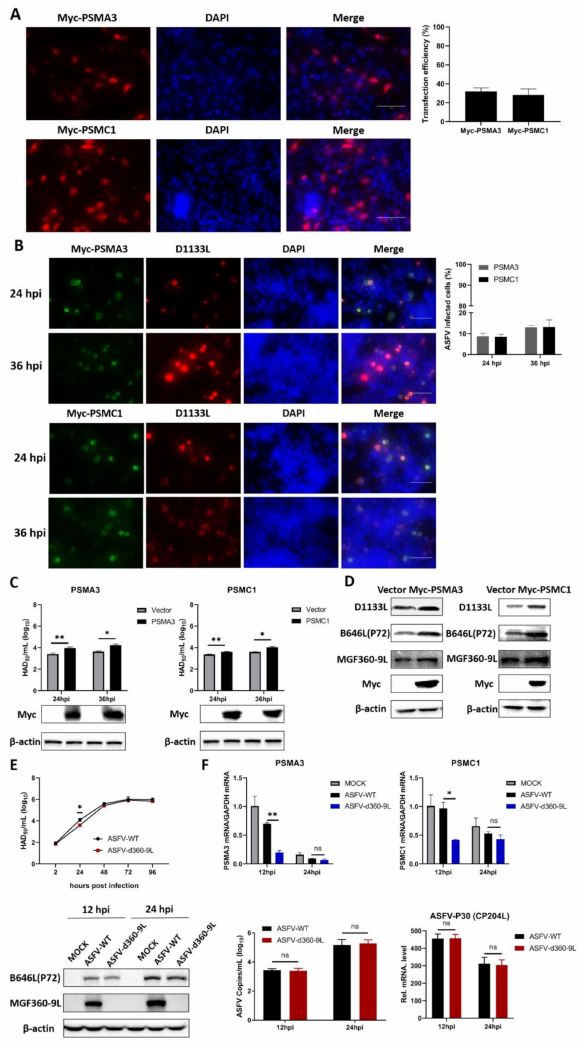
Figure 7. Overexpression host proteins PSMA3 and PSMC1 are beneficial to ASFV replication. ( A ) MA-104 cells were transfected with Myc-PSMA3 (4 µ g/well) or Myc-PSMC1 (4 µ g/well) plasmids. After 24 h, the transfection efficiency was observed by EVOS M5000 cell imaging system. ( B )